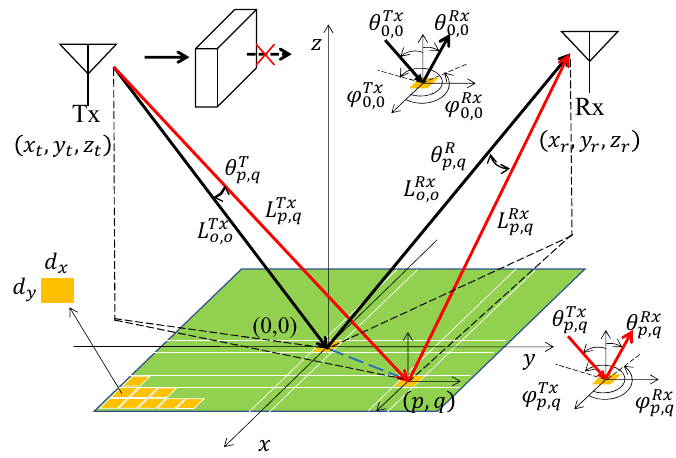
Figure 2. The explanation of RIS-assisted wireless communication in the near-field